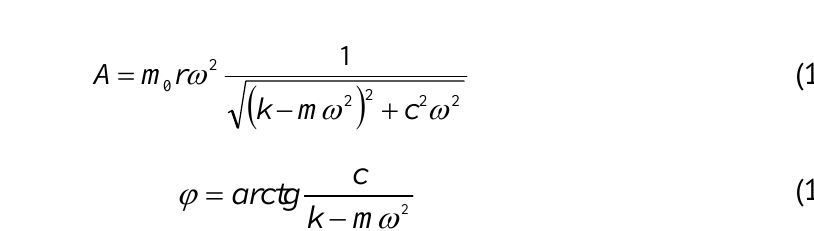
Figure 1. Dynamic calculation